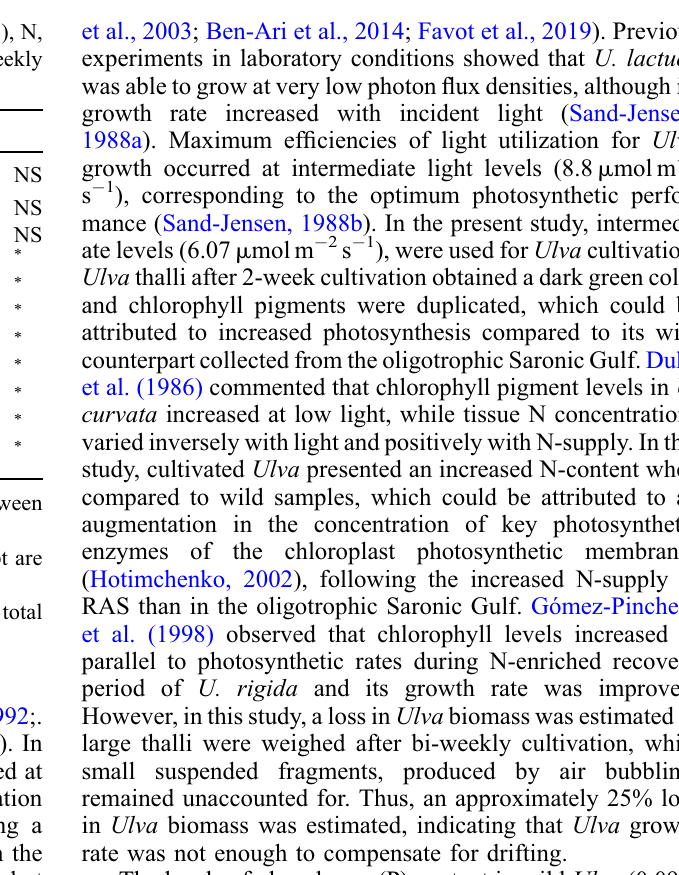
P Means (±SE) and p values for the signi fi cance of differences between control-RAS and Ulva -RAS fi sh groups, are presented. Mean values at the same line with different letter in superscript are signi fi cantly different.